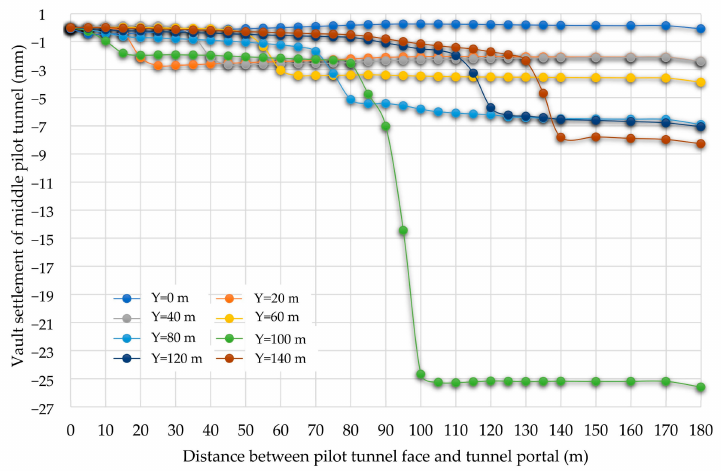
Figure 11. Vault settlement of middle pilot tunnel during pilot tunnel